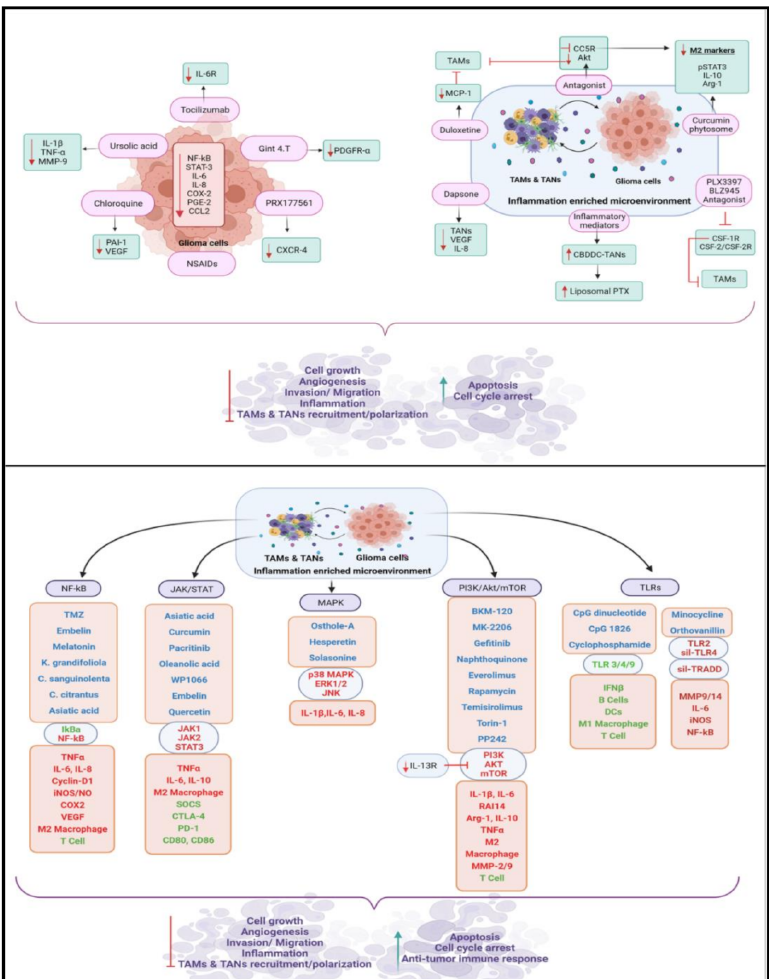
Figure 3. Represents the therapeutic benefits of targeting inflammatory mediators, TAMs, TANs, and signaling pathways in glioma. Red color indicates inhibition/blocking and green color shows activa- tion/upregulation. NF- κ B: Nuclear factor kappa-light-chain-enhancer of activated B cells; JAK/STAT: Janus kinase-signal transducer and activator of transcription; MAPK: Mitogen-activated protein kinase; PI3K/Akt/mTOR: Phosphatidylinositol-3-kinase-mammalian target of rapamycin; TLRs: Toll-like receptors; TAMs: tumor-associated macrophages; TANs: tumor-associated neutrophils; IL-1 β , -6, -8, -10: interleukins-1 β , -6, -8, -10; IL-6R: interleukin-6 receptor; TNF- α : tumor necrosis factor- α ; MMP-2/9/14: matrix metalloproteinase-2/9/14; PDGFR- α : platelet-derived growth fac- tor receptor- α ; COX-2: cyclooxygenase-2; PGE2: prostaglandin E2; PAI-1: plasminogen activator inhibitor-1; VEGF: vascular endothelial growth factor; NSAIDs: non-steroidal anti-inflammatory drugs; CXCR-4: chemokine receptor type 4; STAT 3: signal transducer and activator of transcrip- tion 3; CCL2: chemokine ligand 2; MCP-1: monocyte chemoattractant protein 1; CC5R: chemokine receptor type 5; CBDDC-TANs: cell-based drug delivery carrier—tumor-associated neutrophils; PTX: paclitaxel; pSTAT3: phosphorylated signal transducer and activator of transcription 3; Arg-1: arginase-1; CSF: colony stimulating factor; Akt/PKB: protein kinase B; TMZ: temozolomide; iNOS: inducible nitric oxide synthase; NO: nitric oxide; T cell: T lymphocyte; SOCS: suppressors of cytokine signaling; CTLA-4: cytotoxic T lymphocyte associated protein-4; PD-1: programmed cell death protein-1; CD80/86: cluster of differentiation 80/86; ERK 1/2: extracellular signal-regulated kinase 1/2; JNK: c-Jun N-terminal kinase; RAI14: retinoic acid-induced 14 protein; IFN β : interferon β ; B cells: B lymphocytes; DCs: dendritic cells; sil-TRADD: silencing TNF receptor type 1-associated DEATH domain protein; sil-TLR4: silencing Toll-like receptor